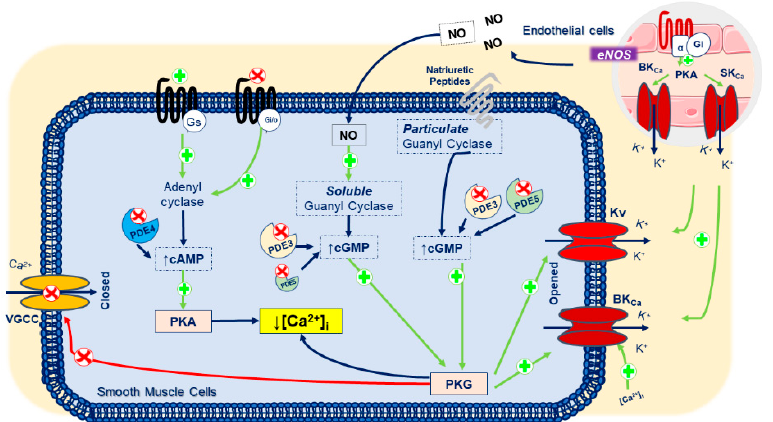
Figure 2. Schematic representation of the mechanisms implicated in activation of Kv and BK Ca channels in human umbilical artery smooth muscle cells (HUASMCs). LEGEND: —G-protein coupled receptor; —peptide receptor; /green arrows—stimulation; /red arrows— inhibition; ? —unknown mechanism; [Ca 2+ ] I —intracellular Ca 2+ concentration; BK Ca —large- conductance Ca 2+ -activated K + channels; Ca 2+ —calcium; cAMP—cyclic adenosine monophosphate; cGMP—cyclic guanosine monophosphate; eNOS—endothelial nitric oxide synthase; K + —potassium; K v —voltage-gated K + channels; NO—nitric oxide; PDE—phosphodiesterase; PKA—protein kinase A; PKG—protein kinase G; SK Ca —small-conductance Ca 2+ -activated K + channels; VGCC—voltage-gated Ca 2+ channels.